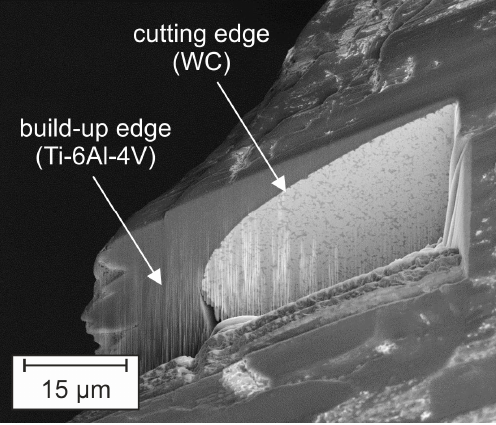
Figure 6. FIB-cut cross section through the cutting edge after machining in laboratory air.